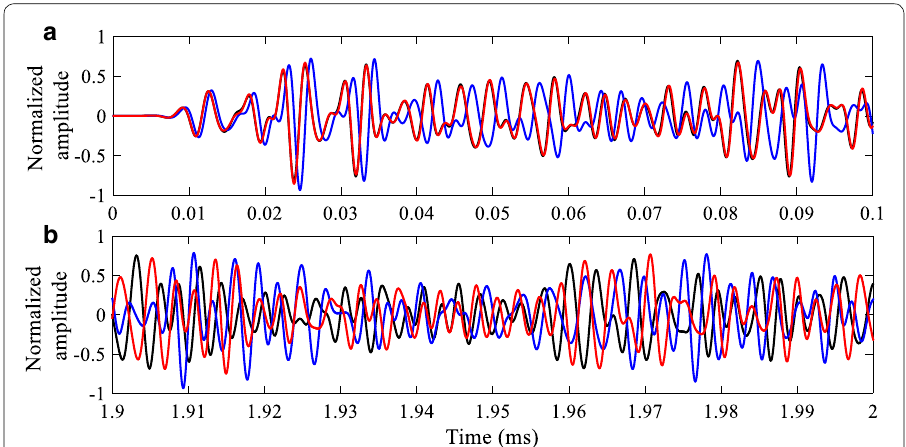
Fig. 13 Black line is the reference waveform recorded at ambient temperature (20 °C), red line is a waveform recorded at 100 °C without introduction of the E ( T ) and K ( T ) laws in the simulation and blue line is a waveform recorded at 100 °C after introduction of the E ( T ) and K ( T ) laws in the simulation a first 0.1 ms of the simulated waveforms b last 0.1 ms of the simulated